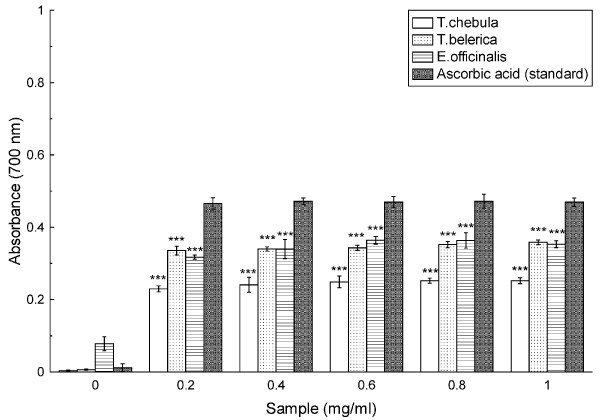
Reducing power assay. The reductive ability of T. chebula, T. belerica and E. officinalis extracts and standard Ascorbic acid. The absorbance (A700) was plotted against concentration of sample. Each value represents mean ± S.D. (n = 6). *** p < 0.001 vs 0 mg/ml.